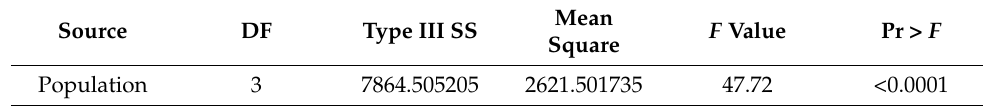
Table A8. 2019 Four Population Seed Number per Capsule.